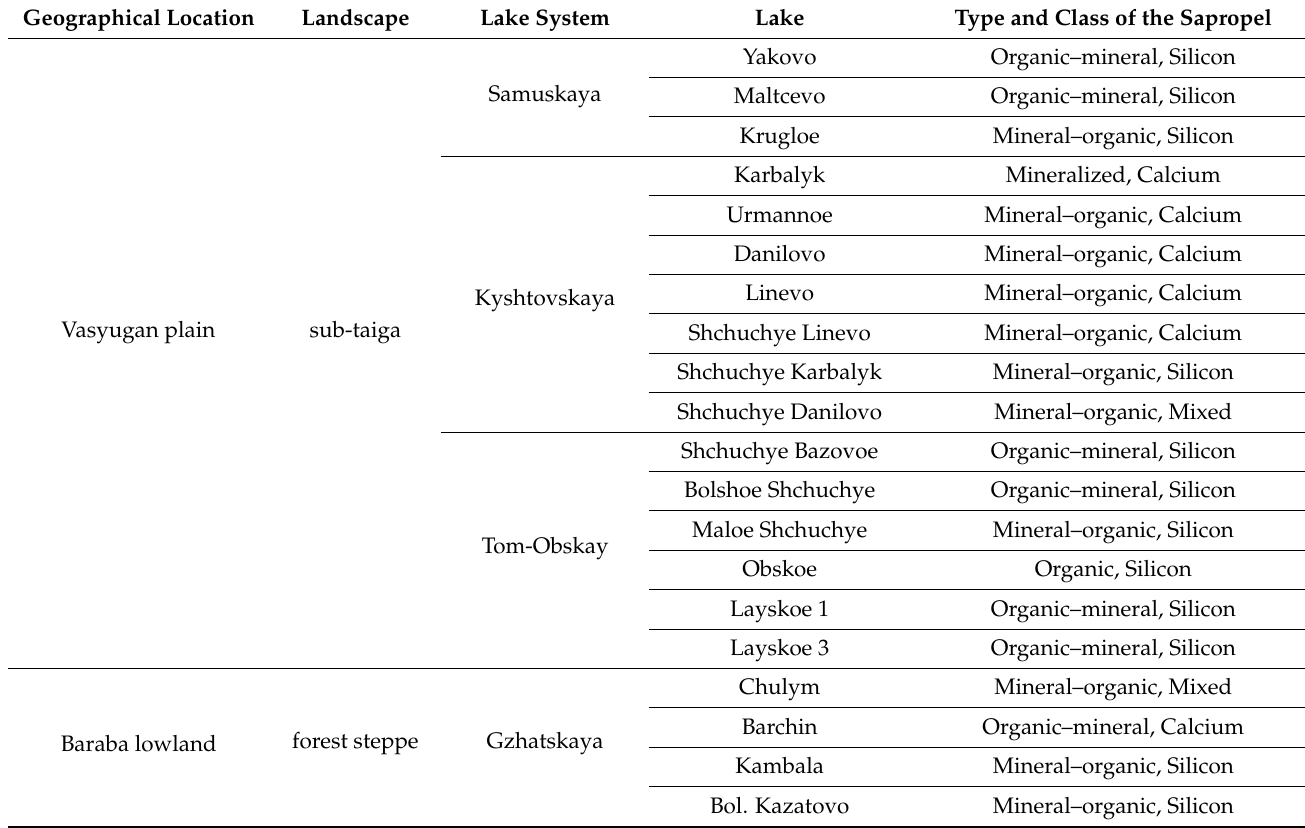
Table A1. Studied lakes (type and class of the sapropels, landscapes, and lake systems). Geographical